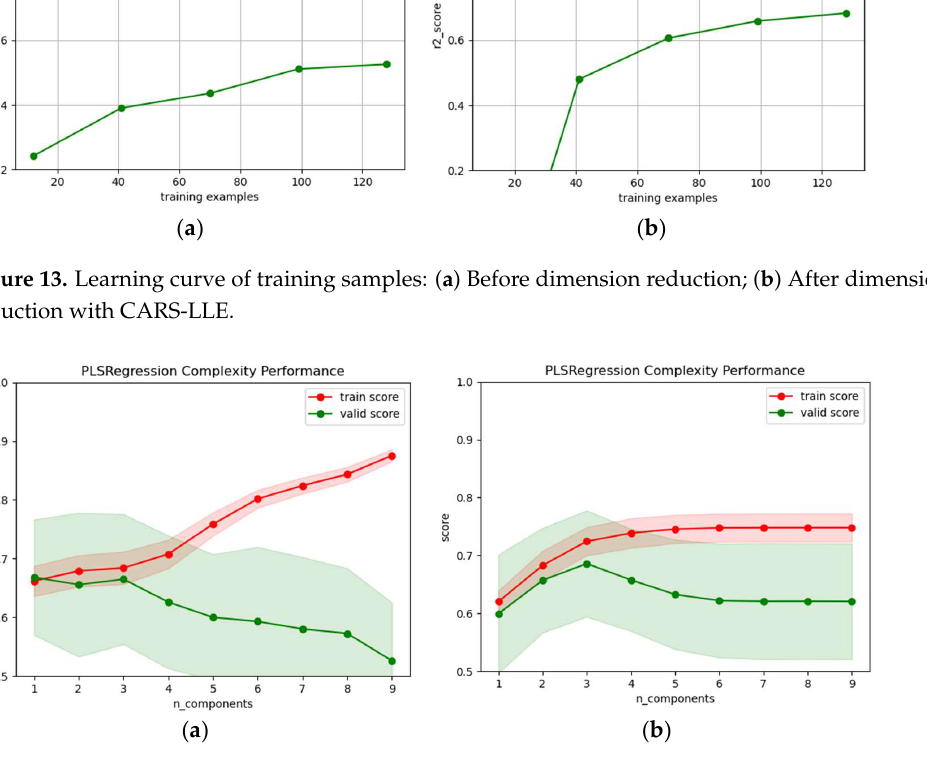
Figure 14. Validation curve of PLS principal component number: ( a ) Before dimension reduction; ( b ) After dimension reduction with CARS-LLE. Table 5. Comparison of results of spectral dimensionality reduction methods.